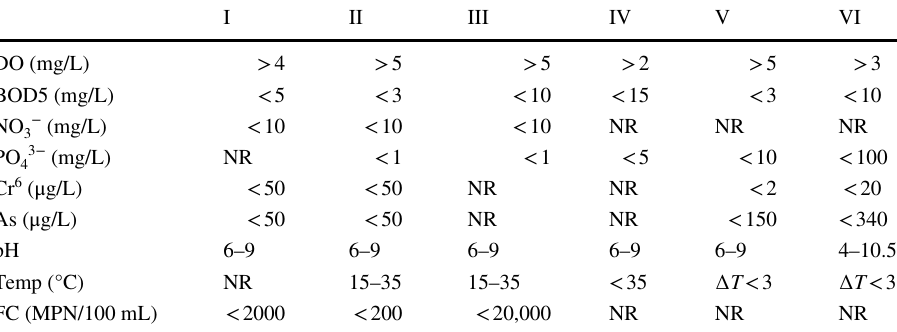
Table 4 Standard values of the analyzed parameters associated with each category of use